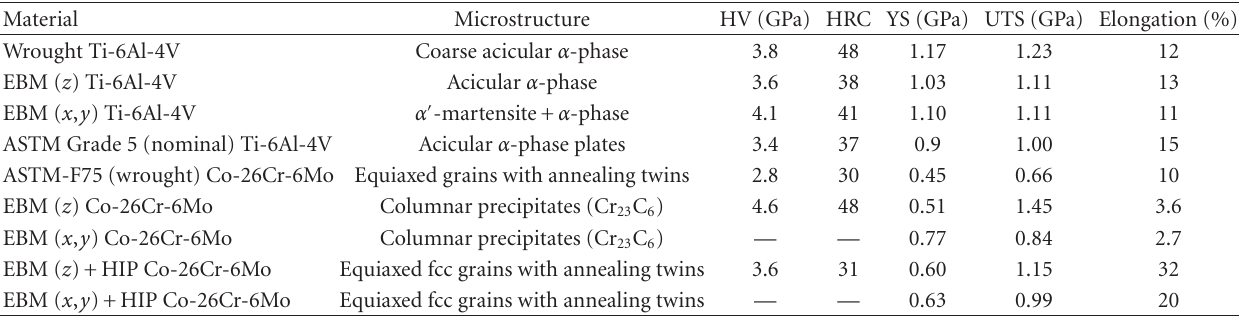
Figure 6: Sti ff ness-density design plot composed of experimental data [6]. The data field for Ti-6Al-4V and Co-29Cr-6Mo is shown shaded. The shaded regime follows a fitted slope, n = 2 . 1. Examples for prototype designs discussed in the text are noted. Table 1: Comparison of mechanical properties for solid Ti-6Al-4V and